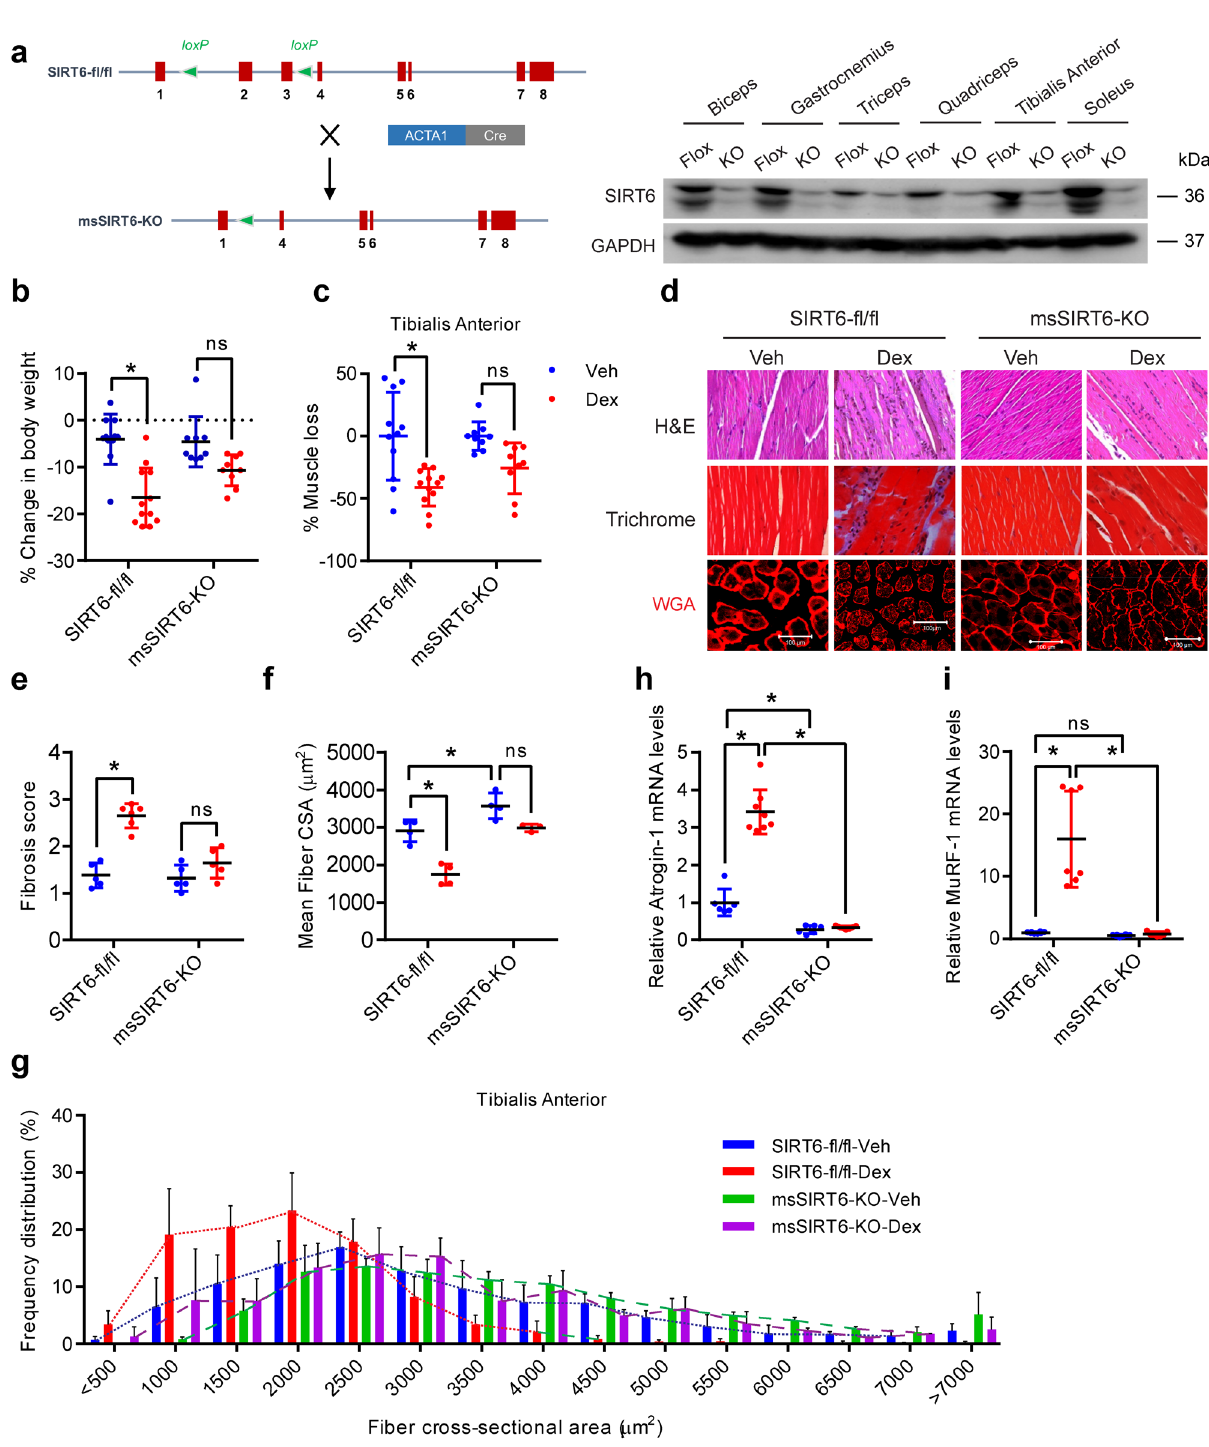
Fig. 3 | SIRT6 depletion protects against Dex-induced reduction in myotube diameter. a Western blot (left) and relative quanti fi cation (right) to con fi rm RNAi- mediateddepletionofSIRT6inprimarymyotubetransfectedwithcontrolsiRNAor siRNA targeting SIRT6. n =6. b Representative confocal images depicting fi ber diameter upon SIRT6 depletion in primary myotubes treated with Dex. Myotubes were stained red using an antibody against myomesin, Scale bar=50 µ m. c Quanti fi cation of fi ber diameter upon SIRT6 depletion in primary myotubes described in b . n =9. d Representative confocal images of MuRF-1/2/3 or Atrogin-1 levels upon SIRT6 depletion in primary myotubes treated with Dex. MuRF-1/2/3 or Atrogin-1 were stained in red and myomesin in green. Scale bar=50 µ m. e MuRF-1/